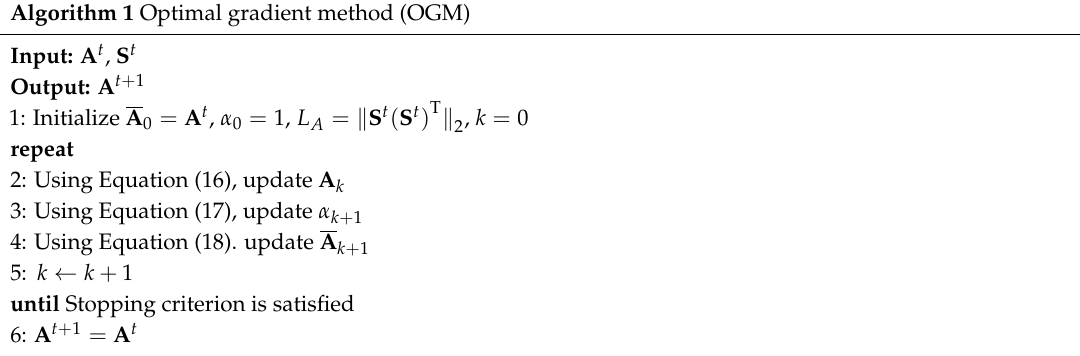
Algorithm 1 Optimal gradient method